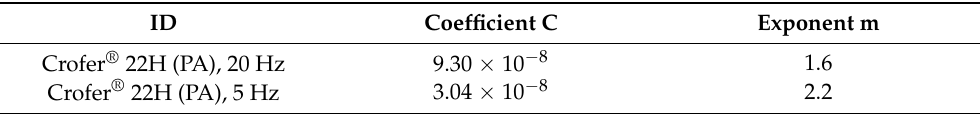
Table 6. “Frequency dependent” fatigue crack growth parameters in precipitation-annealed Crofer ® 22H (PA) at 650 ◦ C.